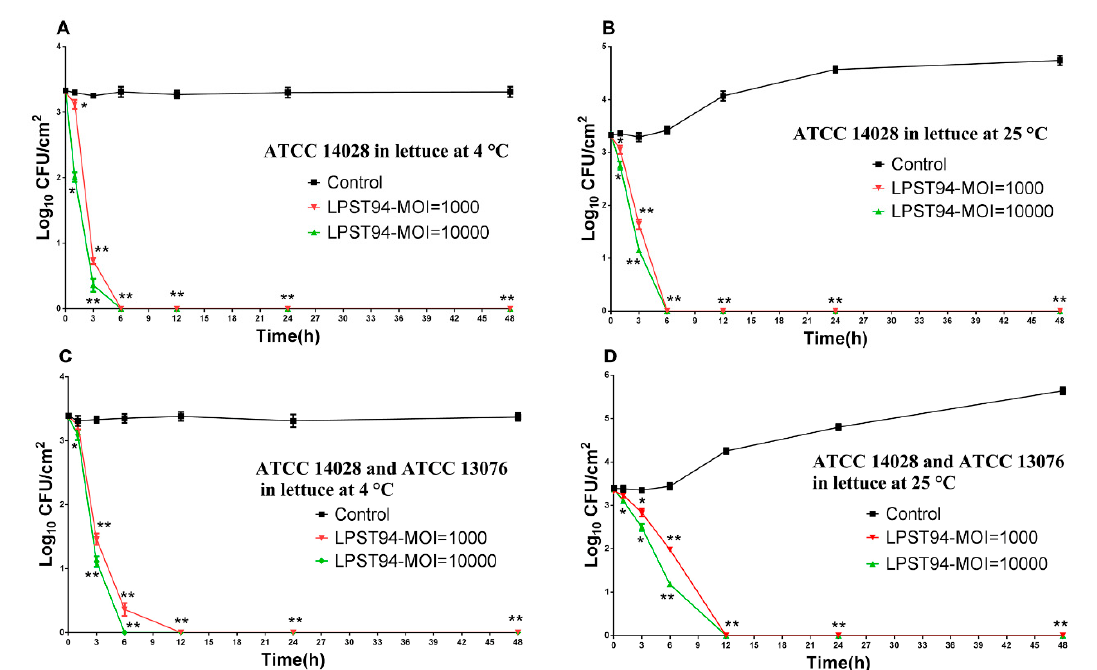
Figure 7. E ff ectiveness of phage LPST94 in reducing the S. Typhimurium ATCC 14028 and S. Enteritidis ATCC 13076 in lettuce. ( A ) E ff ect of phage LPST94 on growth of S. Typhimurium ATCC 14028 on lettuce at 4 ◦ C, ( B ) E ff ect of phage LPST94 on growth of S. Typhimurium ATCC 14028 on lettuce at 25 ◦ C, ( C ) E ff ect of phage LPST94 on growth of Salmonella mixture ( S. Typhimurium ATCC 14028 and S. Enteritidis ATCC 13076) on lettuce at 4 ◦ C, and ( D ) E ff ect of phage LPST94 on growth of Salmonella mixture ( S. Typhimurium ATCC 14028 and S. Enteritidis ATCC 13076) on lettuce at 25 ◦ C. Values represent mean with standard deviation of three determinations. ** Significance of p < 0.01; * Significance of p < 0.05.